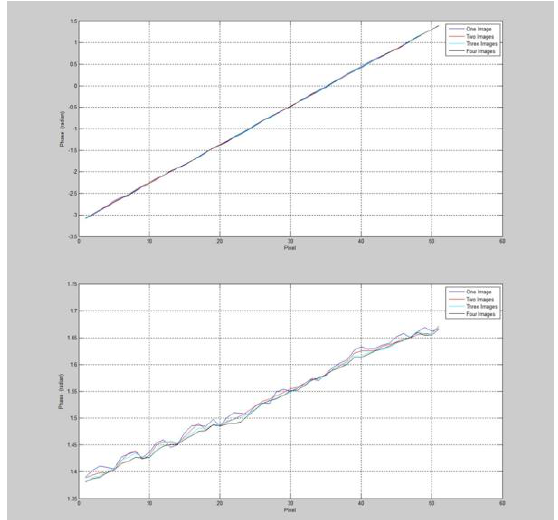
Figure 2. a row of phase map with 1/64 pixel(up) and 1/1024 pixel (down) spatial frequency with different SNR in different colors